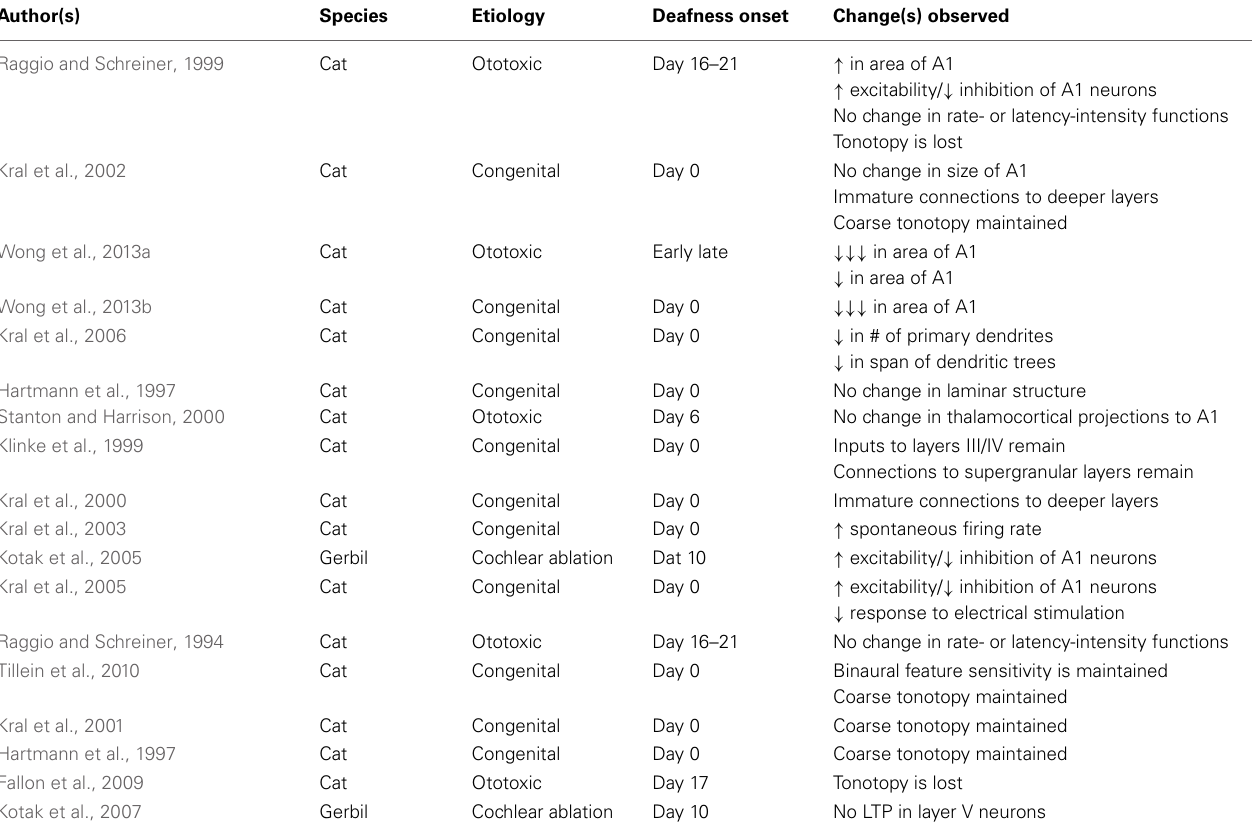
Table 4 | Summary of changes in auditory